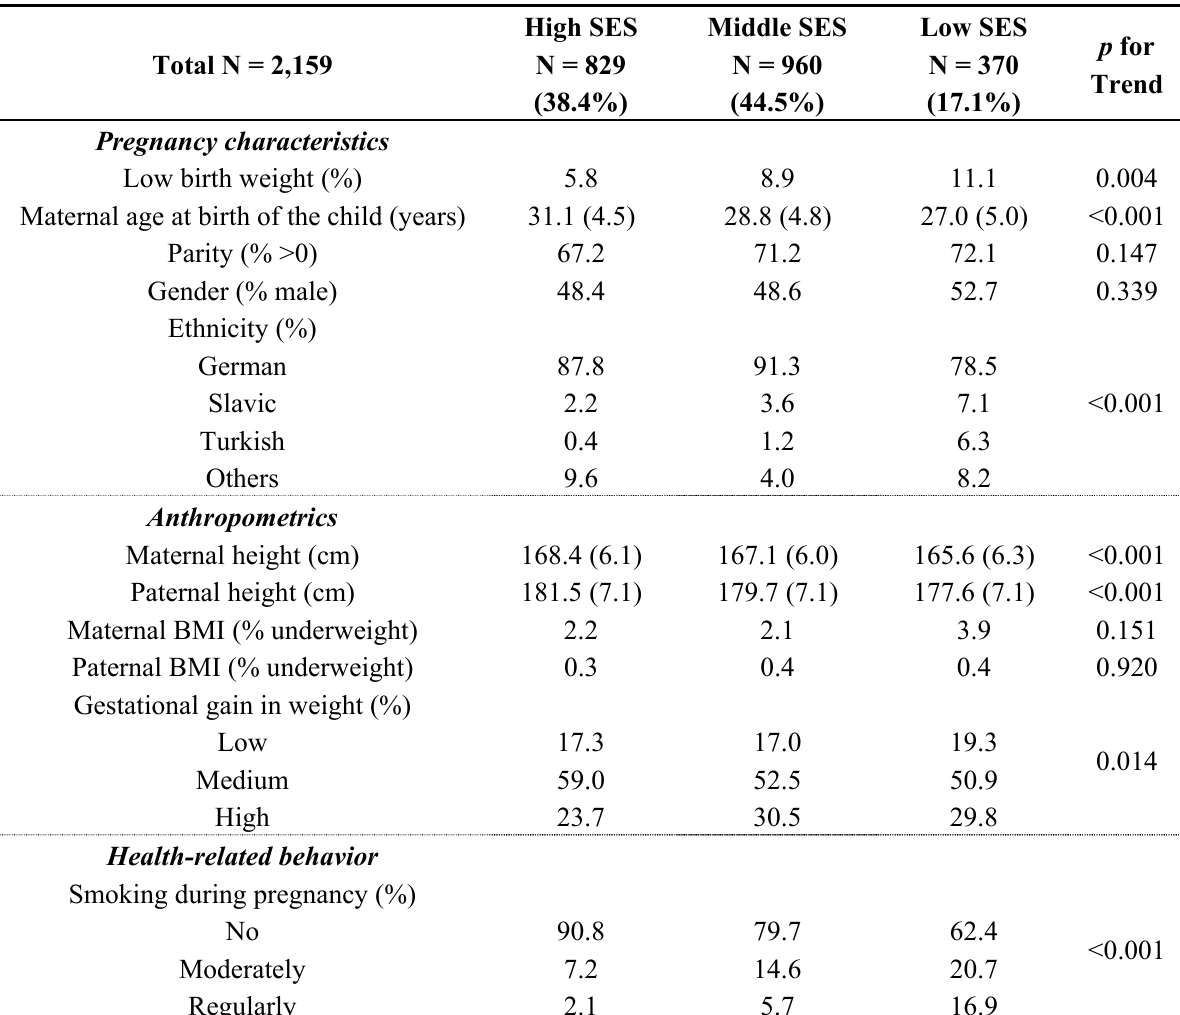
Table 1. Relation between independent and dependent variables, and potential mediators and